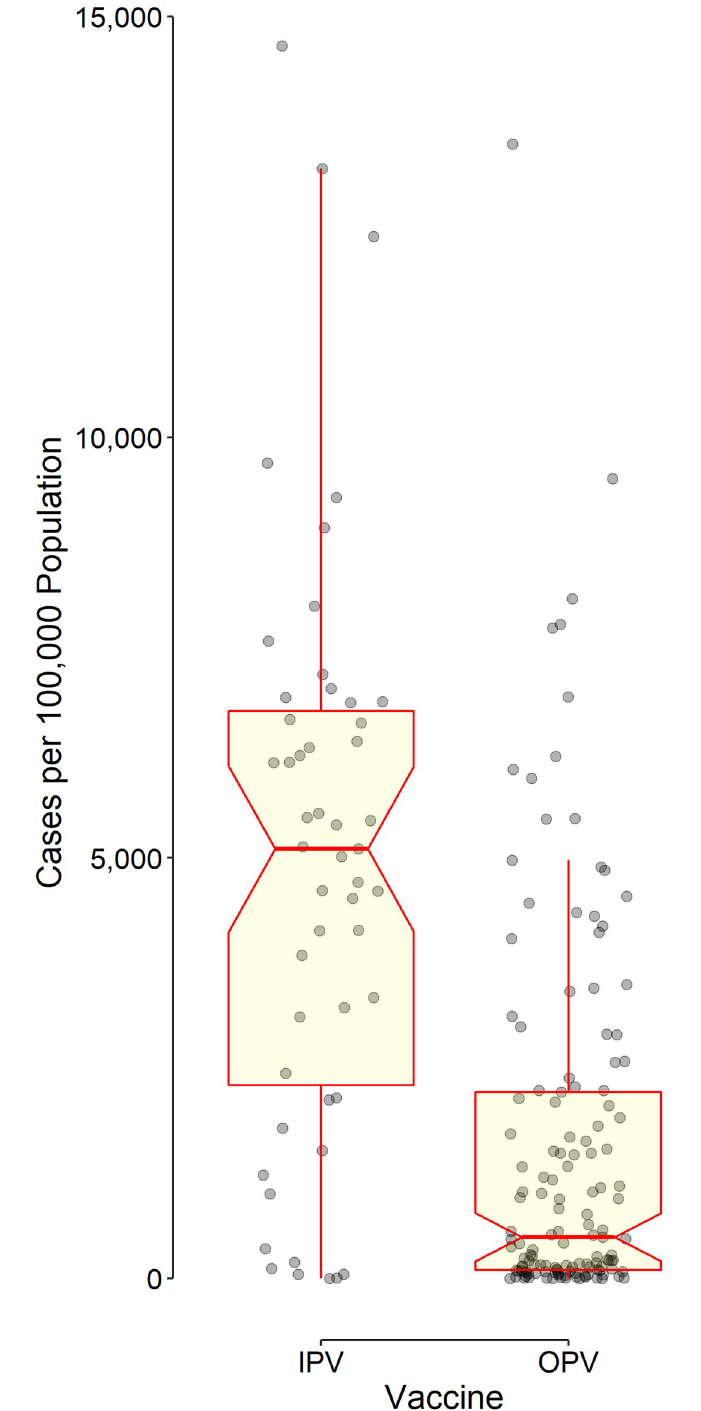
Fig 2. Distribution of data points as well as the box and whisker plot indicating the cumulative number of cases diagnosed with COVID-19 per 100,000 population stratified by the type of polio vaccine used in each country. The horizontal line in the middle of each box indicates the median. The notch represents the 95% confidence interval of the median. The bottom and top borders of the box show the 25 th and 75 th percentiles, respectively. The lower whisker indicates the smallest data point within 1.5 times the interquartile range (IQR) less than the 25 th percentile; the upper whisker indicates the largest point within 1.5 × IQR greater than the 75 th percentile. Points greater than the upper whisker and smaller than the lower whisker were considered outliers. All outliers were included in data analyses.